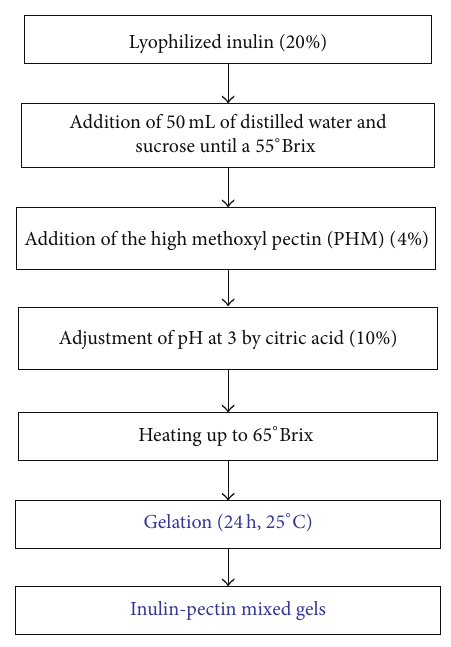
Figure 3: Diagram of inulin-pectin gels